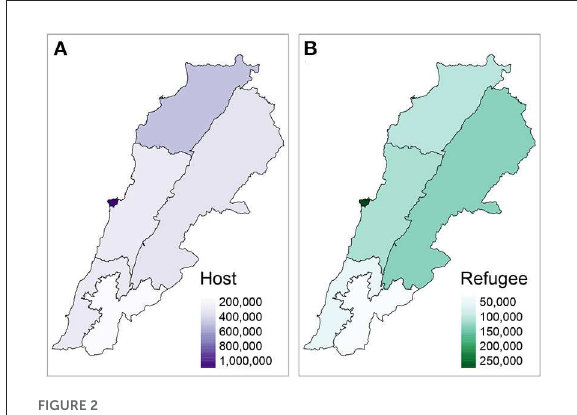
FIGURE2 Distribution of Facebook users across different regions of Lebanon for the host (A) and refugee (B)